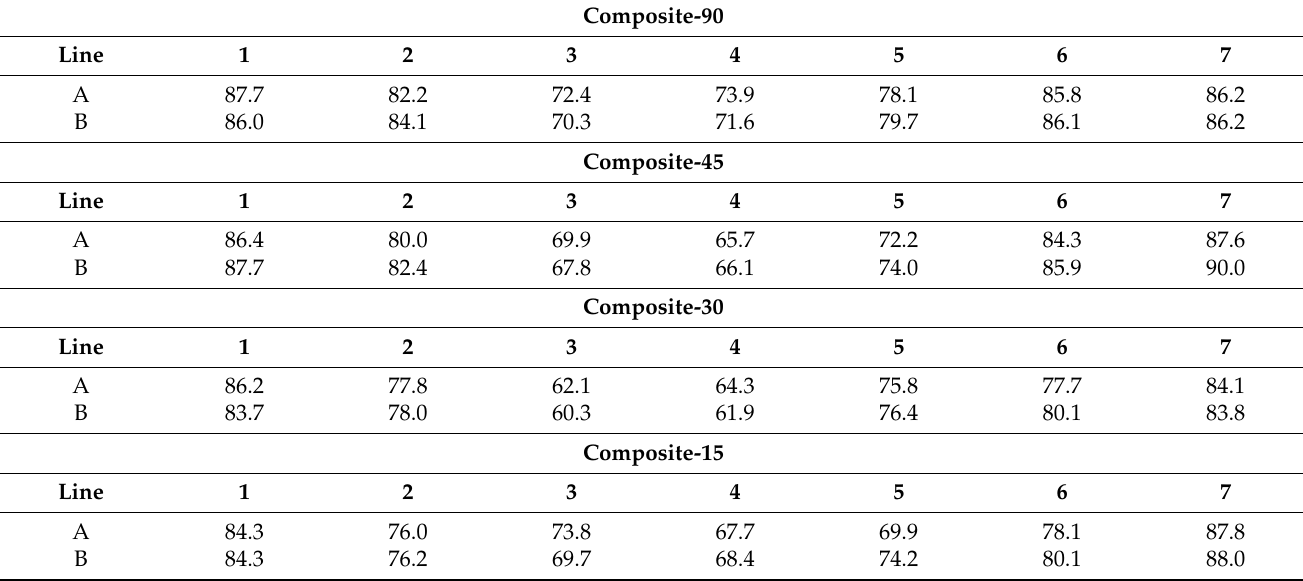
Figure 7. Lines and points to measure fiber intersection angles after drawing. Table 3. Fiber intersection angles at different points of composite specimens after drawing.